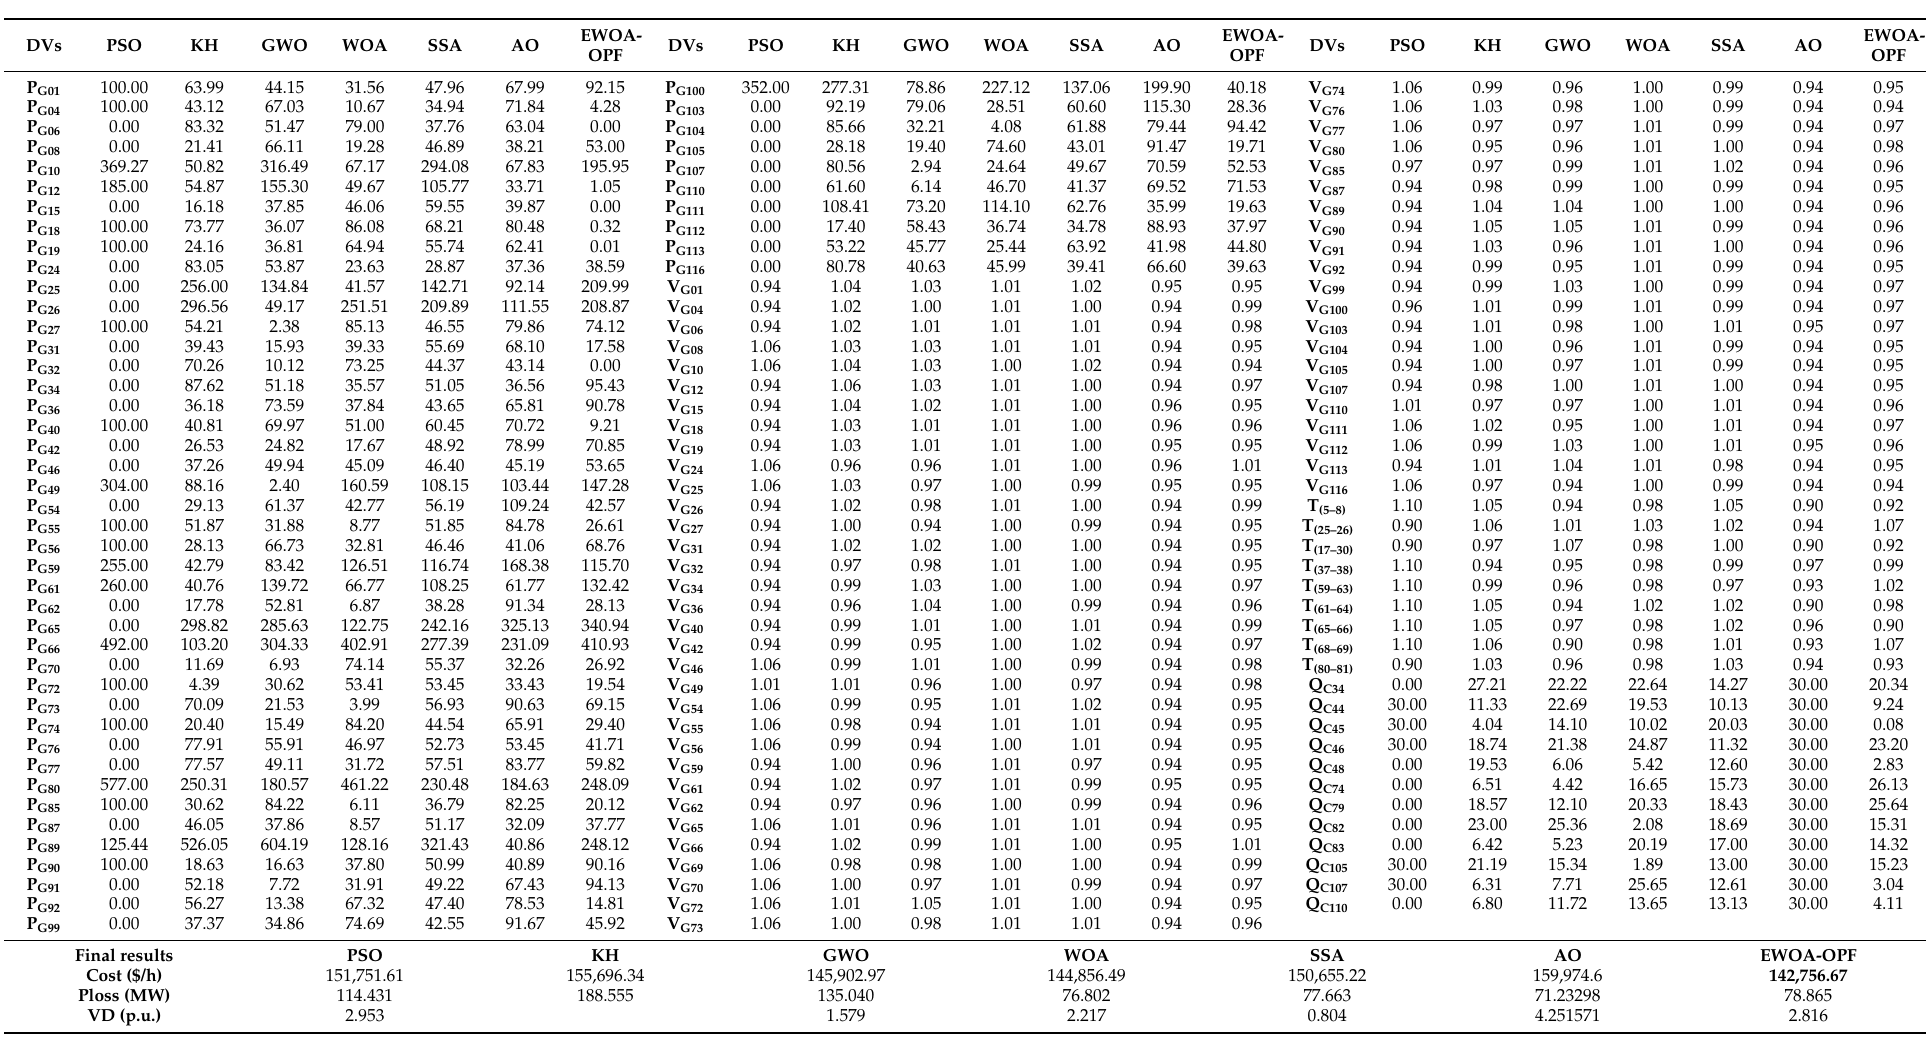
Table A1. Results of OPF for IEEE 118-bus test system on Case